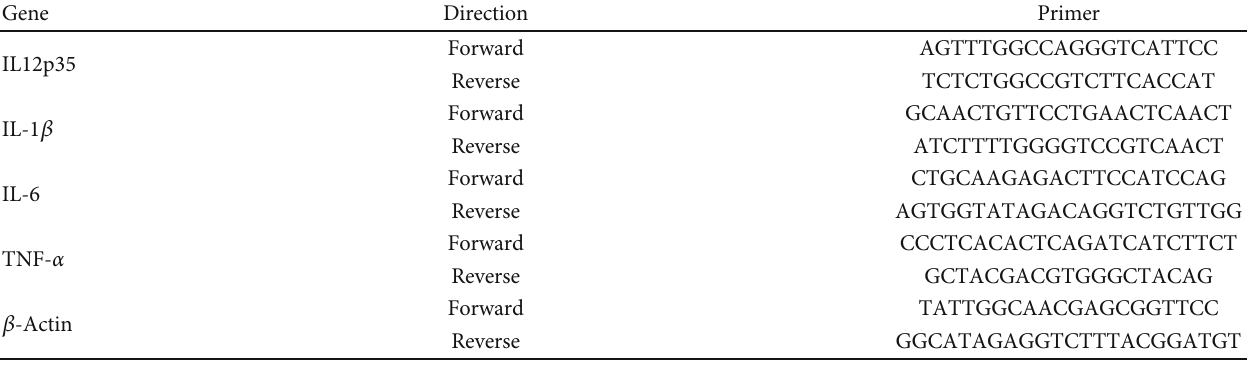
Table 1: Primers used for